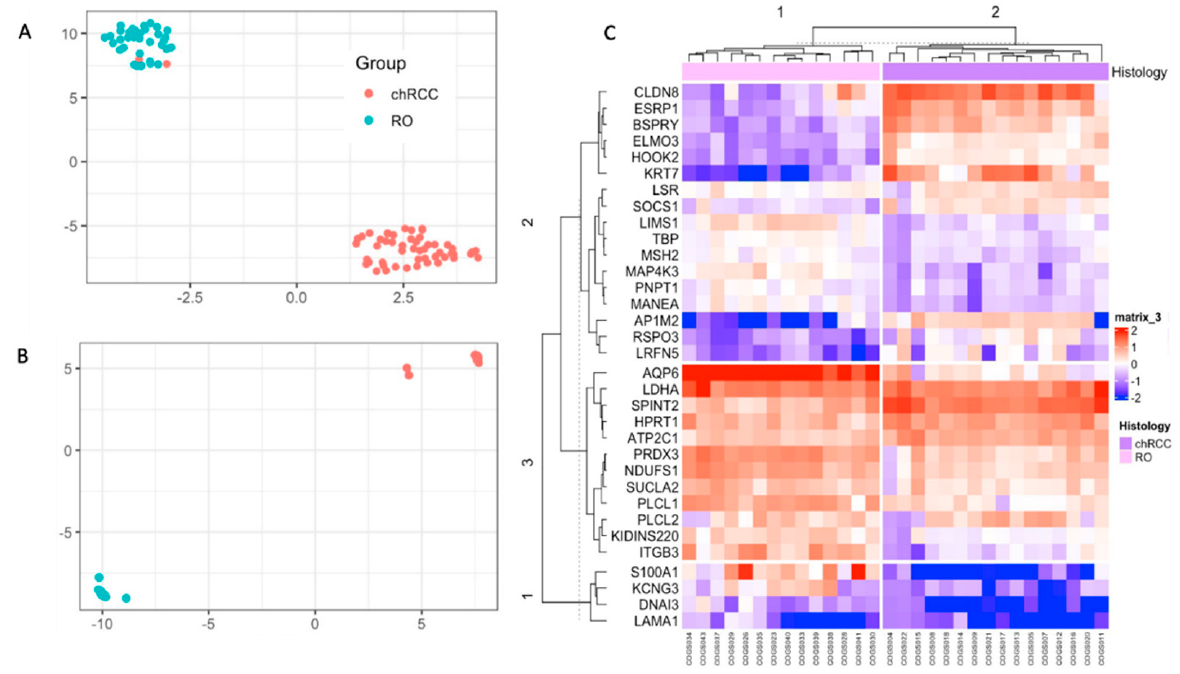
Figure 2. Unsupervised classification of the NanoString data with UMAP and Hierarchical Clustering. ( A ): UMAP of discovery data showing two clusters were used to train the supervised UMAP model. ( B ): UMAP projection of the NanoString data using the trained UMAP model from A. ( C ): Hierarchical clustering showing two clusters for the samples, congruent with their histological clas- sification.